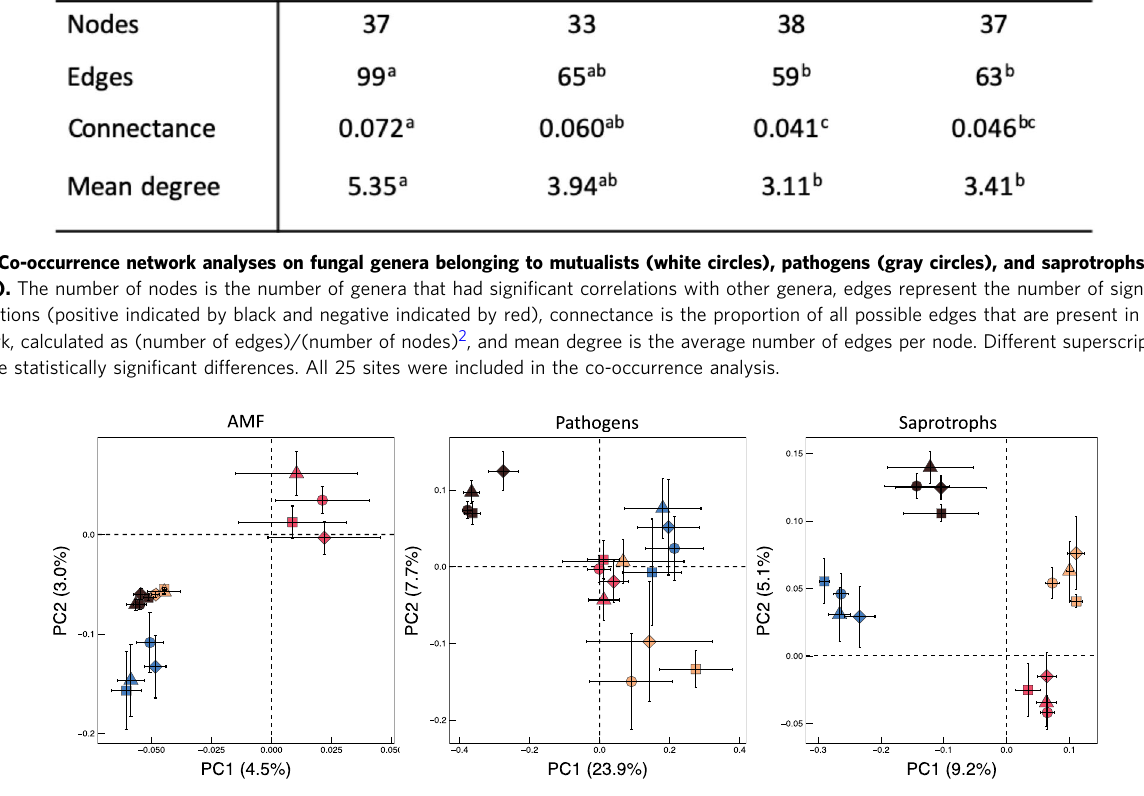
Fig. 4 Principal coordinate analyses of Bray – Curtis distances of Hellinger transformed relative abundance data showing dissimilarities among communities for mutualists (AMF), pathogens, and saprotrophs occurring in North America (pink, n = 16), Europe (blue, n = 3), Africa (maroon, n = 3), and Australia (peach, n = 3) in either control plots (circles) or plots that had received nitrogen (squares), phosphorus (triangles), or both (diamonds). Error bars around the means represent standard error. Communities of all guilds differed among continents using PERMANOVA ( p < 0.001), but nutrient treatments had no consistent effect on composition, most likely due to high community turnover among sites and low sequence numbers resulting in low power. Results were not different when dissimilarities were assessed based on Raup-Crick transformed presence/absence